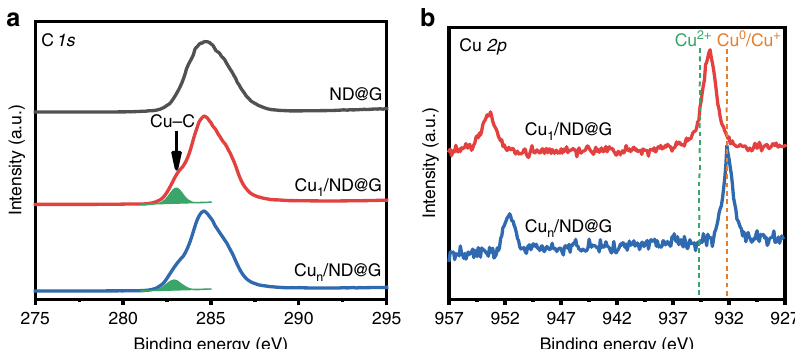
Fig. 3 XPS measurements of ND@G support and Cu 1 /ND@G and Cu n /ND@G catalysts. a C 1 s XPS of ND@G, Cu 1 /ND@G, and Cu n /ND@G. b Cu 2 p XPS of Cu 1 /ND@G and Cu n /ND@G